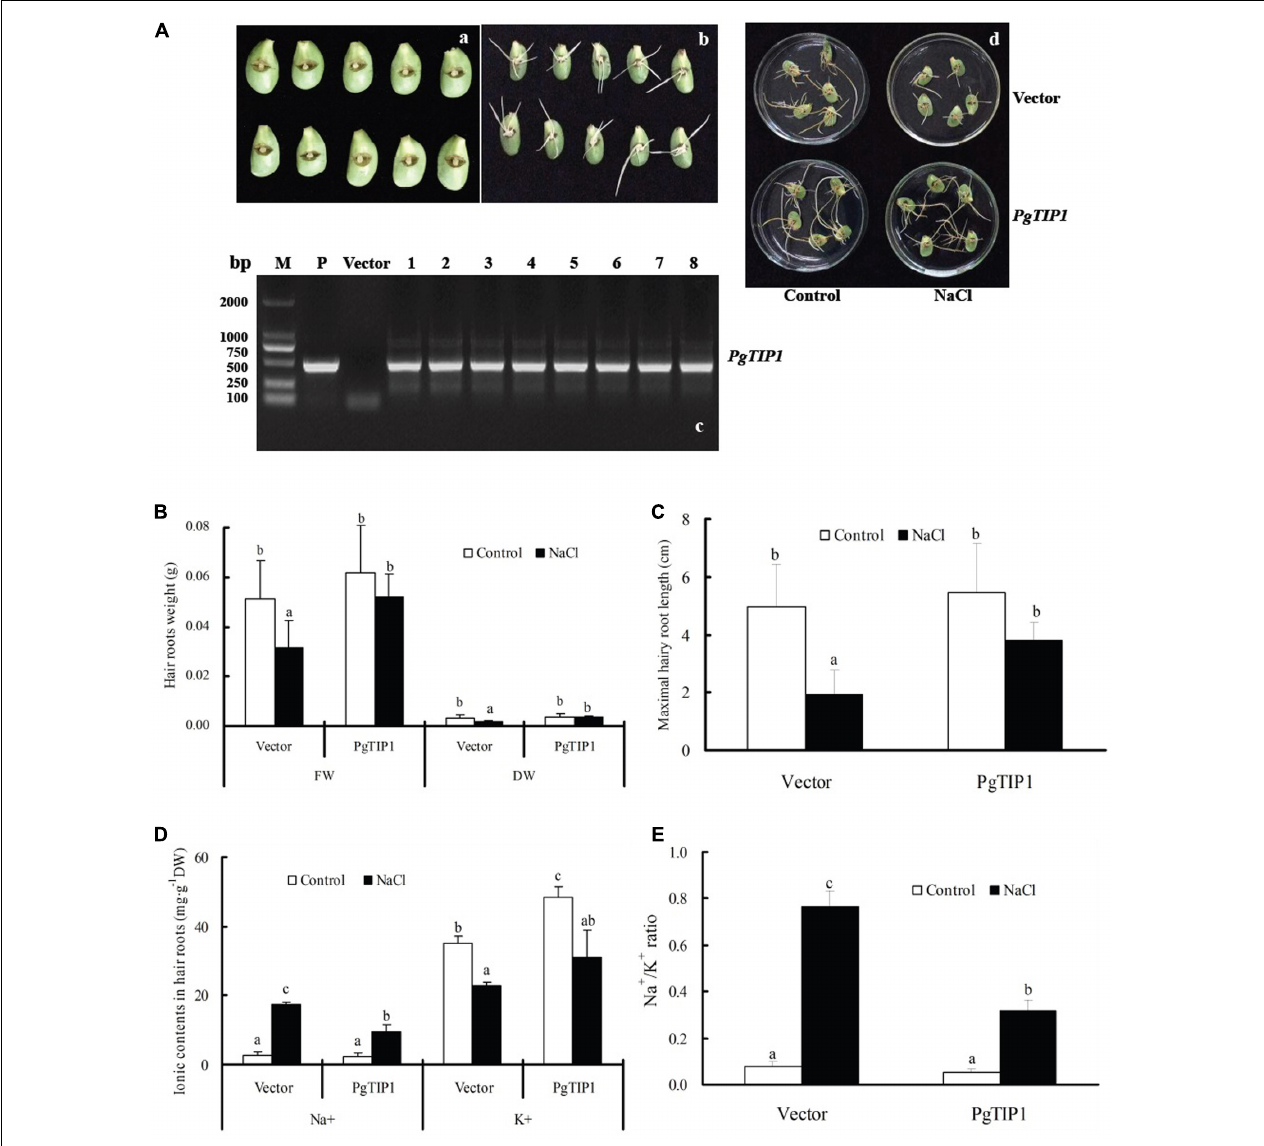
FIGURE 1 | Growth characteristics of hairy roots of PgTIP1- transformed soybean cotyledons under salt stress. ( A-a,b ) Culture of hairy roots of PgTIP1- transformed soybean cotyledons. (A-c) PCR verification, (A-d) changes in growth phenotype, (B) FW and DW, (C) maximal hairy root length, (D) contents of Na + and K + , and (E) Na + /K + ratio in the hairy roots under 80 mM NaCl treatment for 5 days. Each bar represents as means ± SD for each treatment ( n = 3; or n = 10 for fresh weight or maximal length of hairy roots), means in bars followed by different letters show significant difference ( P < 0.05) between the parameters of the empty vector - transformed and PgTIP1- transfromed soybean cotyledon hairy